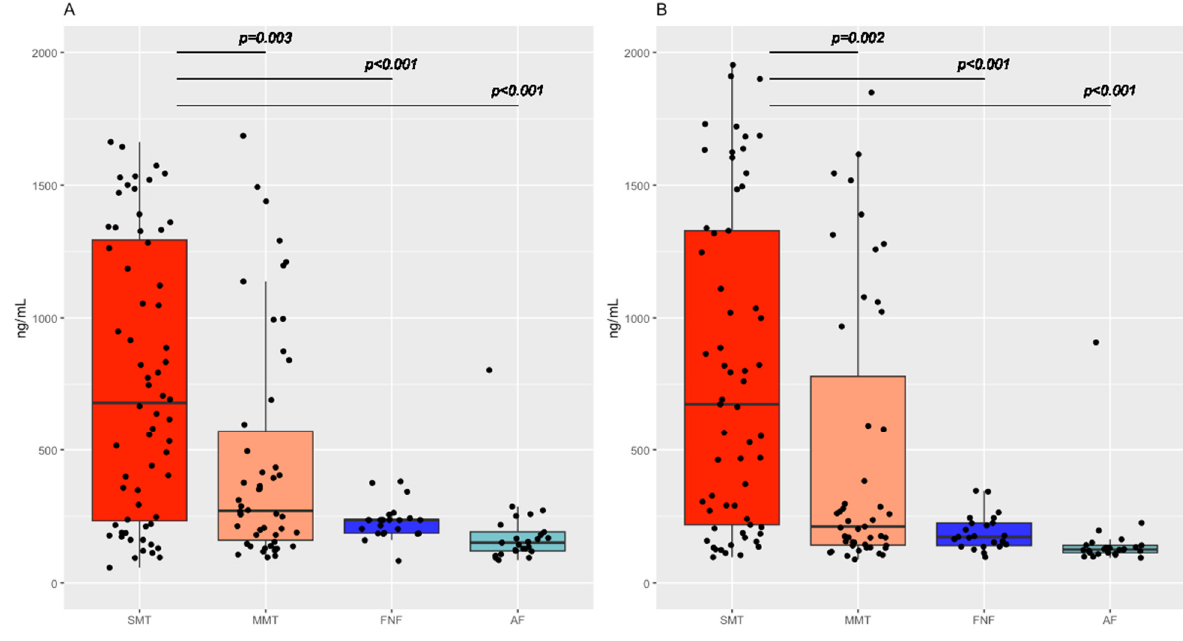
Figure 1. Boxplots for the distribution of cfDNA concentration in: ( A ) serum and ( B ) plasma in all groups investigated. Severe multiple trauma (SMT); moderate multiple trauma (MMT); femur neck fracture (FNF); ankle fracture (AF). Table 2. cfDNA concentrations in serum and plasma in various disease groups. In patients with severe polytrauma, differences in cfDNA concentrations in severe versus moderate TBI and in first week survival and non-survival are